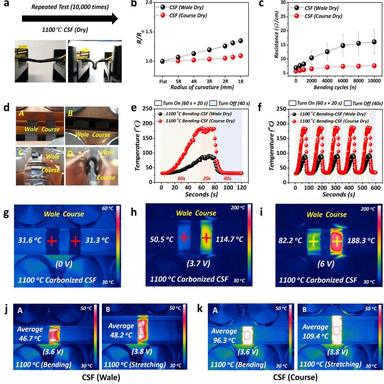
Repeated resistance test of the CSF, heat management of the CSF and heater applications. a Photo images of the 10,000 cycle repeated bending test of the CSF (Dry, 1100 �C). b Resistance data for the CSF (Dry, 1100 �C) during the bending tests. c Variation analysis of the CSF (Dry, 1100 �C) data during the bending tests. d Photo images of the CSF (Dry, Wale & Course) during the experiments (bending and stretching). e Thermal analysis data of the CSF (Dry, 1100 �C) over time (120 s, 1–6 V). f Repeated thermal